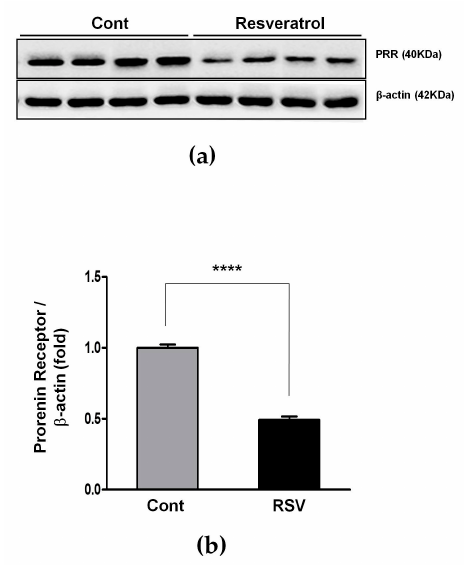
Figure 3. Effects of resveratrol on the expression of prorenin receptors. ( a ) Representative western blot analysis of prorenin receptors expression. ( b ) Prorenin receptors levels were decreased in the RSV group. Quantitative analysis of the results is shown (**** p < 0.0001).